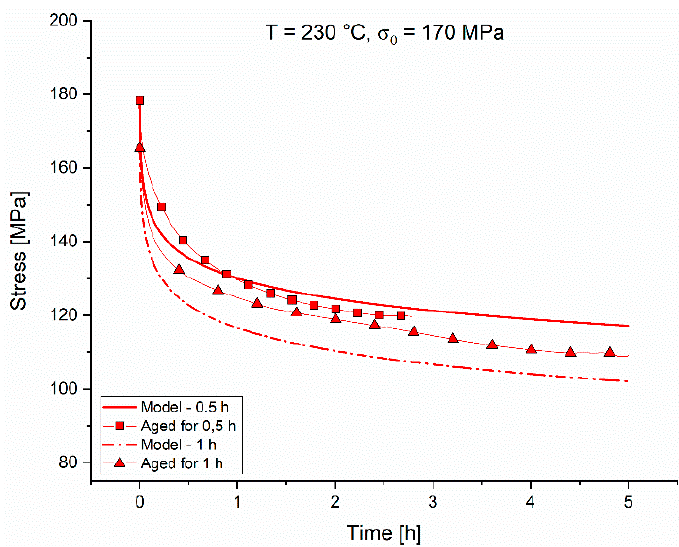
Figure 10. Comparison of experimental and simulated stress relaxation curves, tested in aged condition at 230 °C with a test stress of 170 MPa.